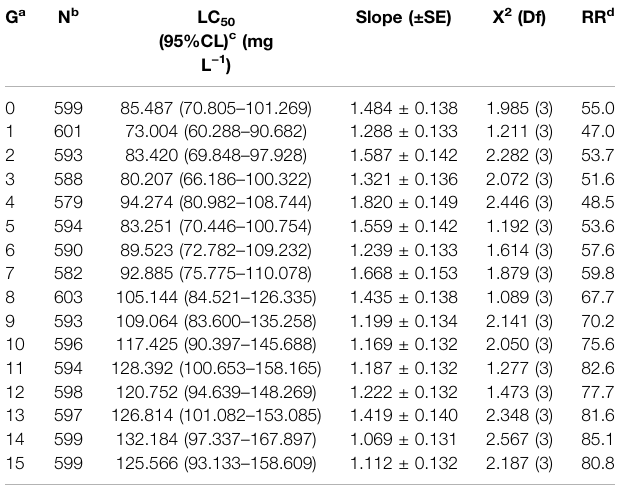
TABLE 1 | Selection of cyantraniliprole resistance in the CYAN-R strain of Bemisia tabaci . G a N b LC 50 (95%CL) c